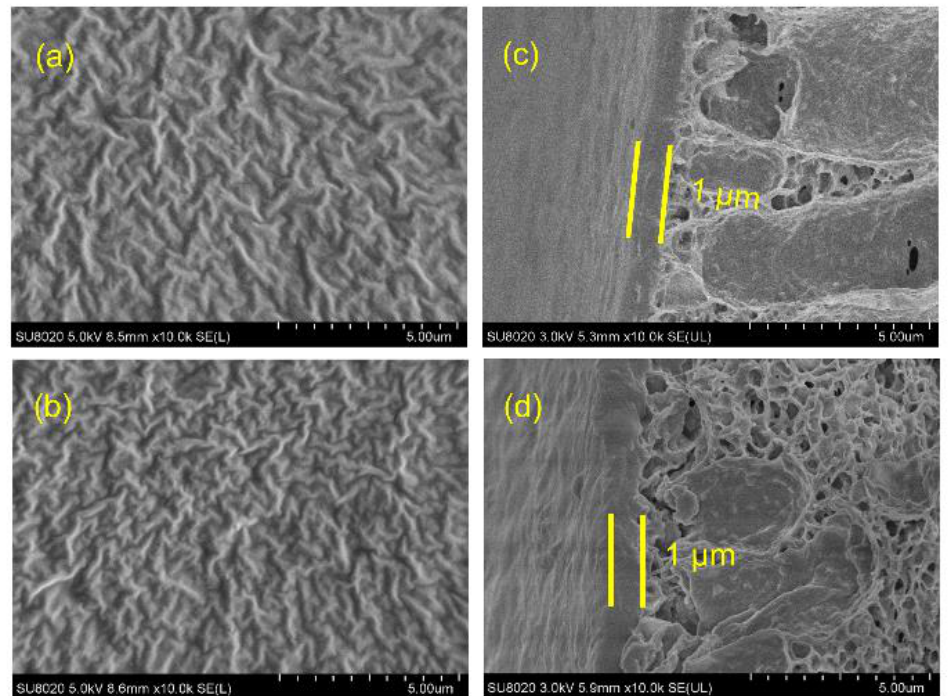
Figure 4. The surface SEM images of ( a ) Pebax-2533 membrane and ( b ) 0.6 wt % T( p -OCH 3 )PPCoCl / Pebax-2533 membrane, and the cross-section SEM images of ( c ) Pebax-2533 membrane and ( d ) 0.6 wt % T( p -OCH 3 )PPCoCl / Pebax-2533 membrane.